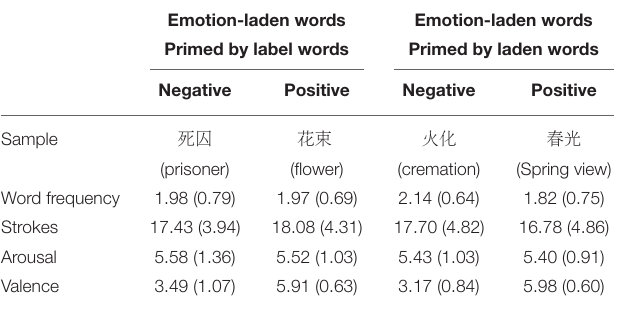
TABLE 1 | Mean and SD in brackets for word characteristics for Chinese emotion-laden words as primes. Emotion-laden words